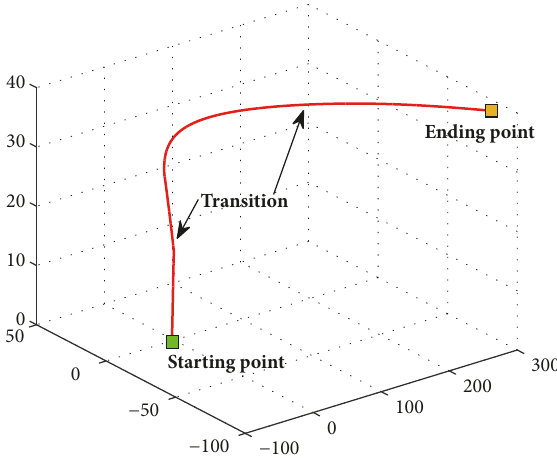
Figure 13: The pitch and desired pitch in experiment.